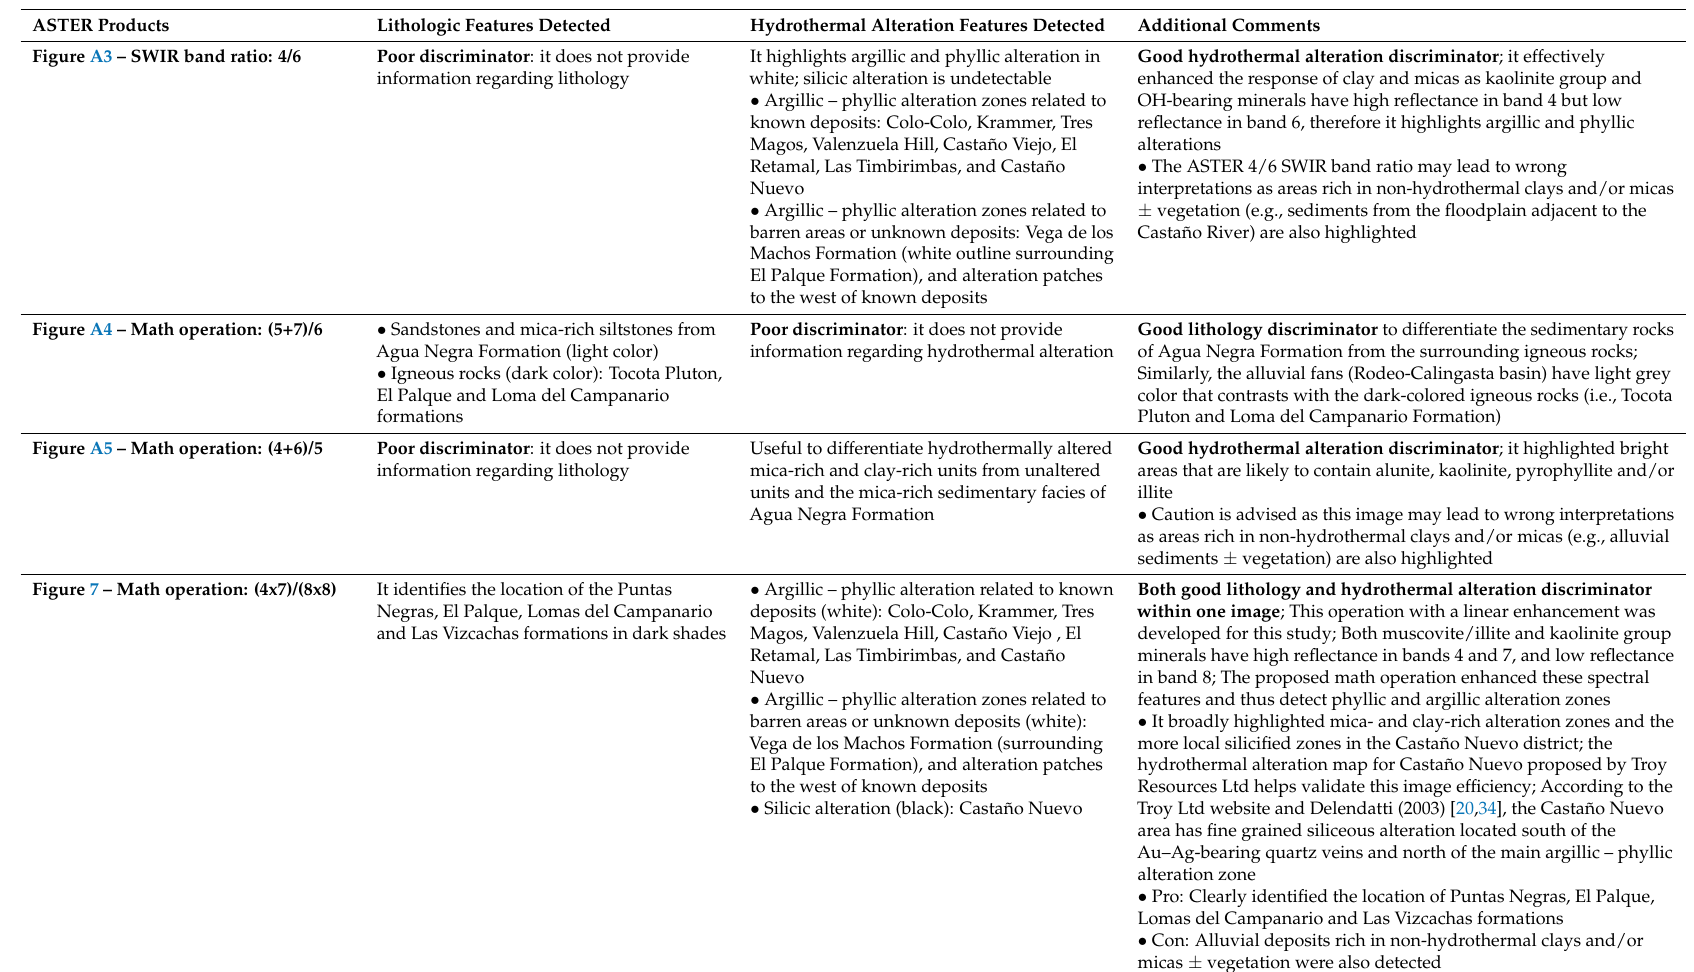
Figure A3 – SWIR band ratio: 4/6